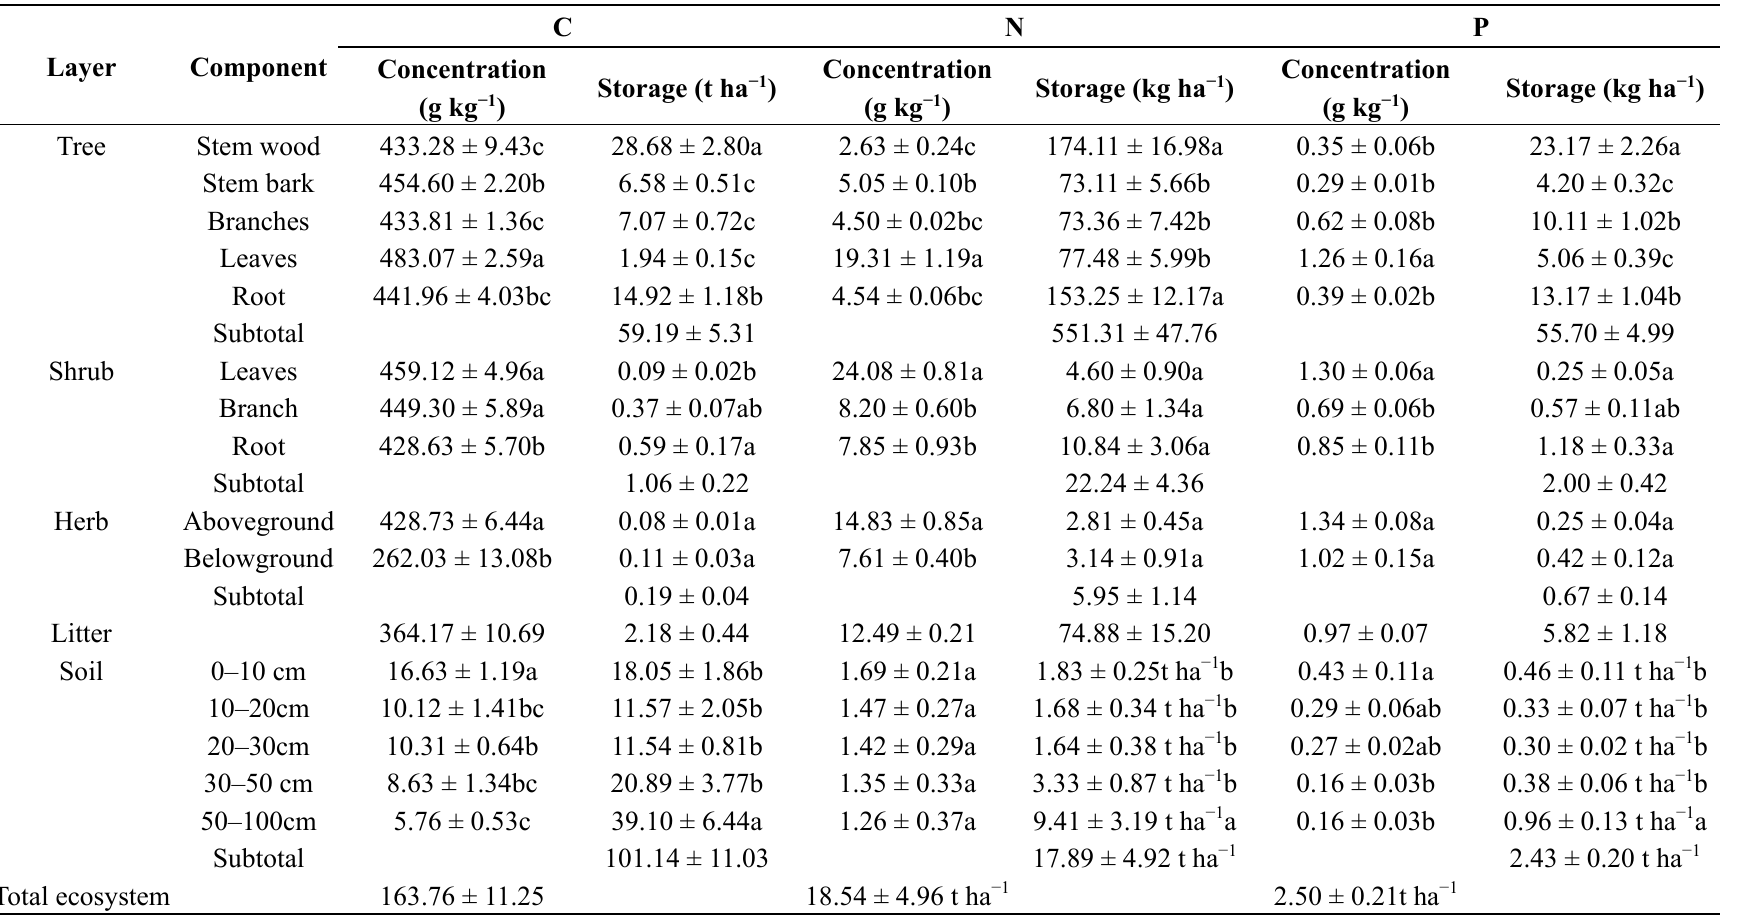
Table 3. C, N and P concentrations and storage distribution of a Chinese cork oak forest in the south slope of the Qinling Mountains, China.